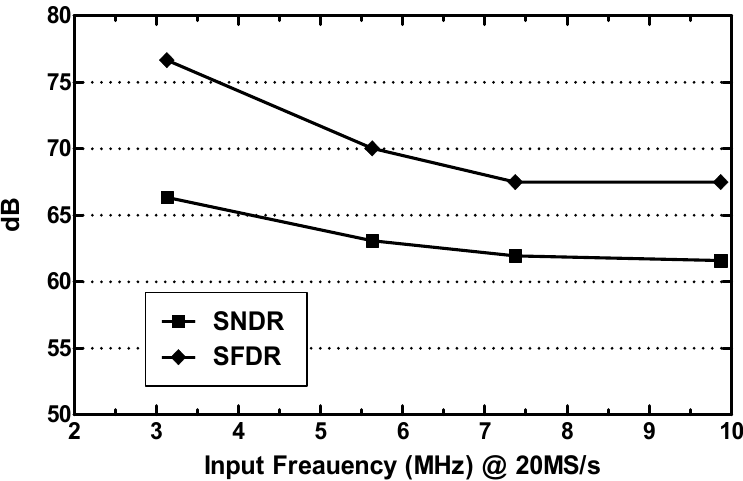
Figure 8. Measured output spectrum at 20MS/s with a 3-MHz input.